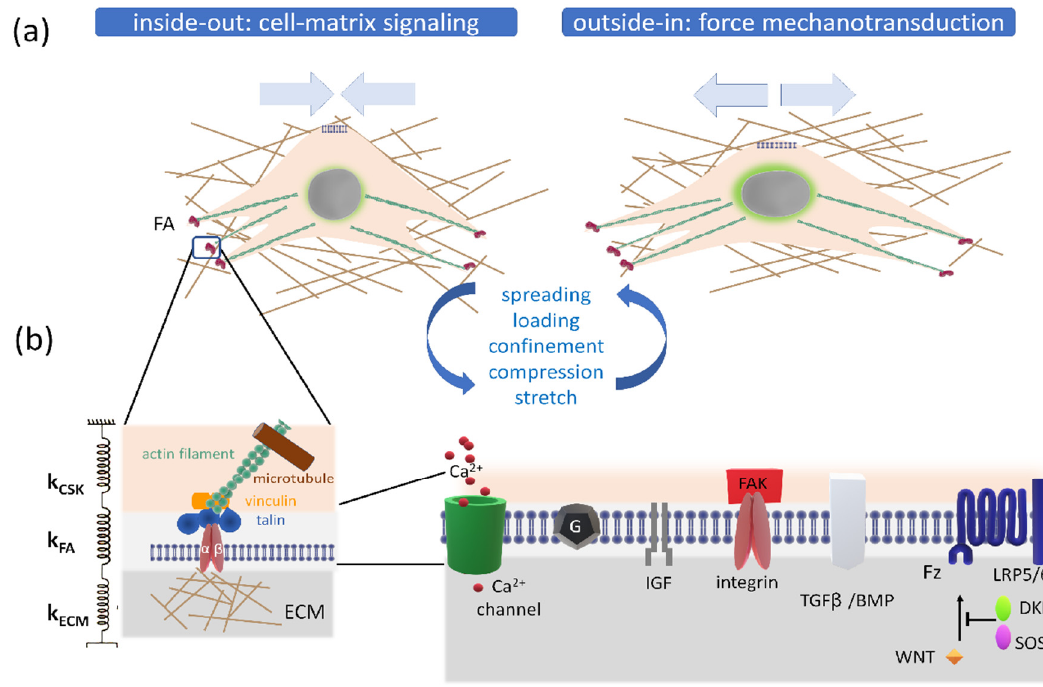
Figure 3. ( a ) Representation of inside-out and outside-in mechanotransduction signals. Focal adhesions (FAs) serve as crucial sites for transferring forces in both directions. Integrins are coupled to the cytoskeleton via molecules such as vinculin, talin and α -actin. ( b ) Protein network clusters across the extracellular matrix, transmembrane proteins and cytoskeleton regions of a spread cell. On the right side, three nonlinear spring series conceptualize the mechanical linkage between the cytoskeleton, focal adhesion complex and extracellular matrix, with respective nonlinear spring constants: k CSK , k FA , k ECM . On the left side, a zoom of the membrane portion is represented. Mechanical signals perceived by membrane-bound receptors such as stretch-activated Ca 2+ channels, integrins, G proteins, IGF and TGF β and/or BMP receptors are stimulated by mechanical forces and converted into a proper biological response (Table 2). The ECM and intracellular pathways are biochemically coupled by mechanotransduction pathways: mechanical resistance to intrinsic forces regulates the stability of focal adhesion complex that contains focal adhesion kinase (FAK), which phosphorylates and activates mechanoresponsive signaling elements. Line with an arrowhead indicates a positive action, and line with a bar indicates inhibition.